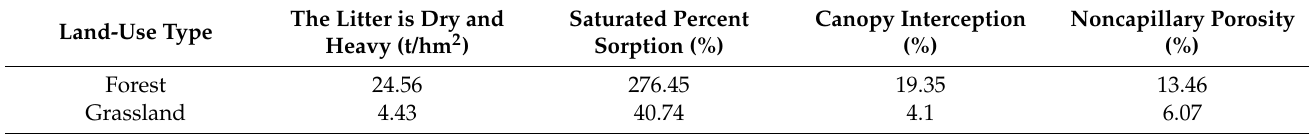
Table 3. Water conservation parameters of each land